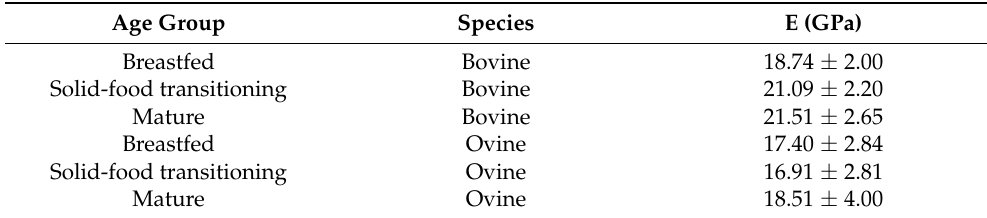
Table 4. Elastic modulus results presented as each age group’s means with their respective standard deviation.